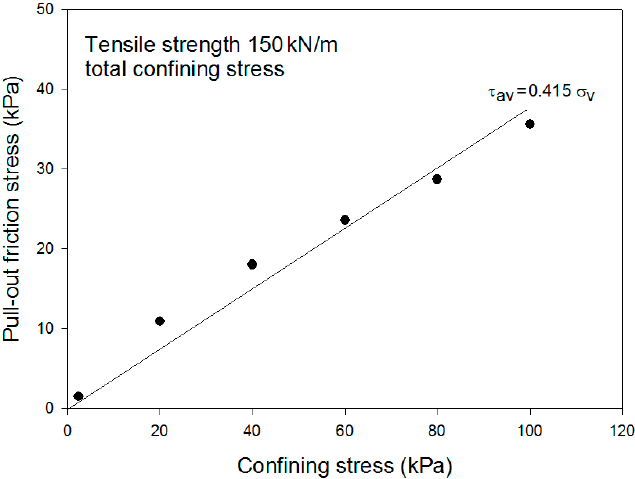
Figure 12. Relationship curve between confining stress and pullout frictional stress by total confining stress (T g = 150 kN/m).